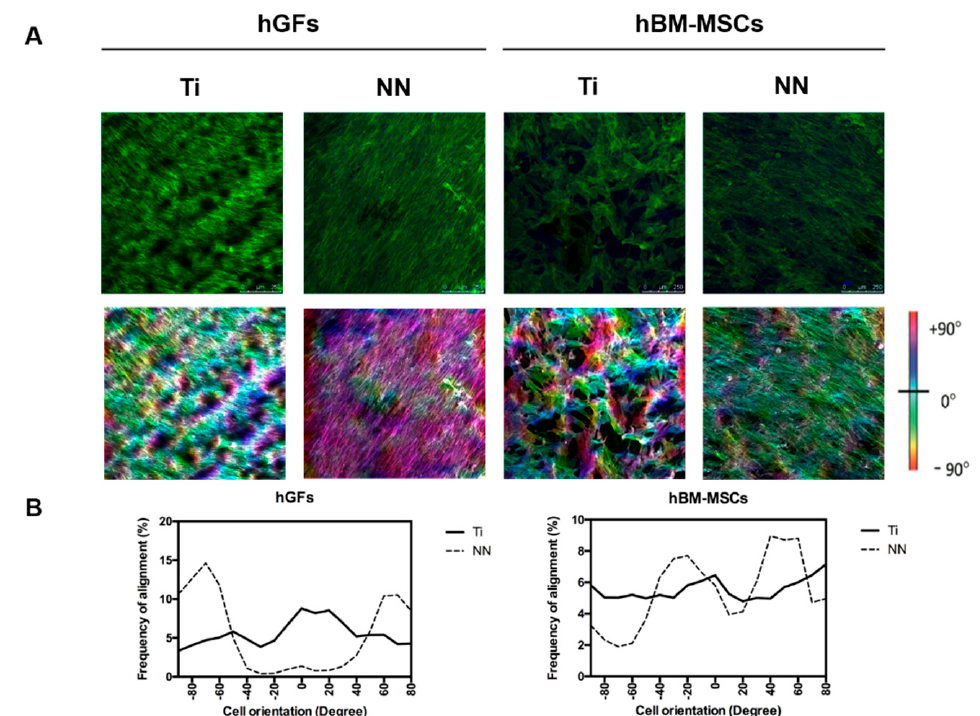
Figure 4. Cell orientation on the nanostructured surfaces. ( A ) The images in the upper row represent hGFs and hBM-MSCs stained with Phalloidin-FITC (green) and DAPI (blue) ( n = 2). Images in the middle row show actin fibers orientation degree with different colours through the surface analysed using ImageJ software. ( B ) The graphs represent the % of pixels in each orientation angle for both cell types for each surface.